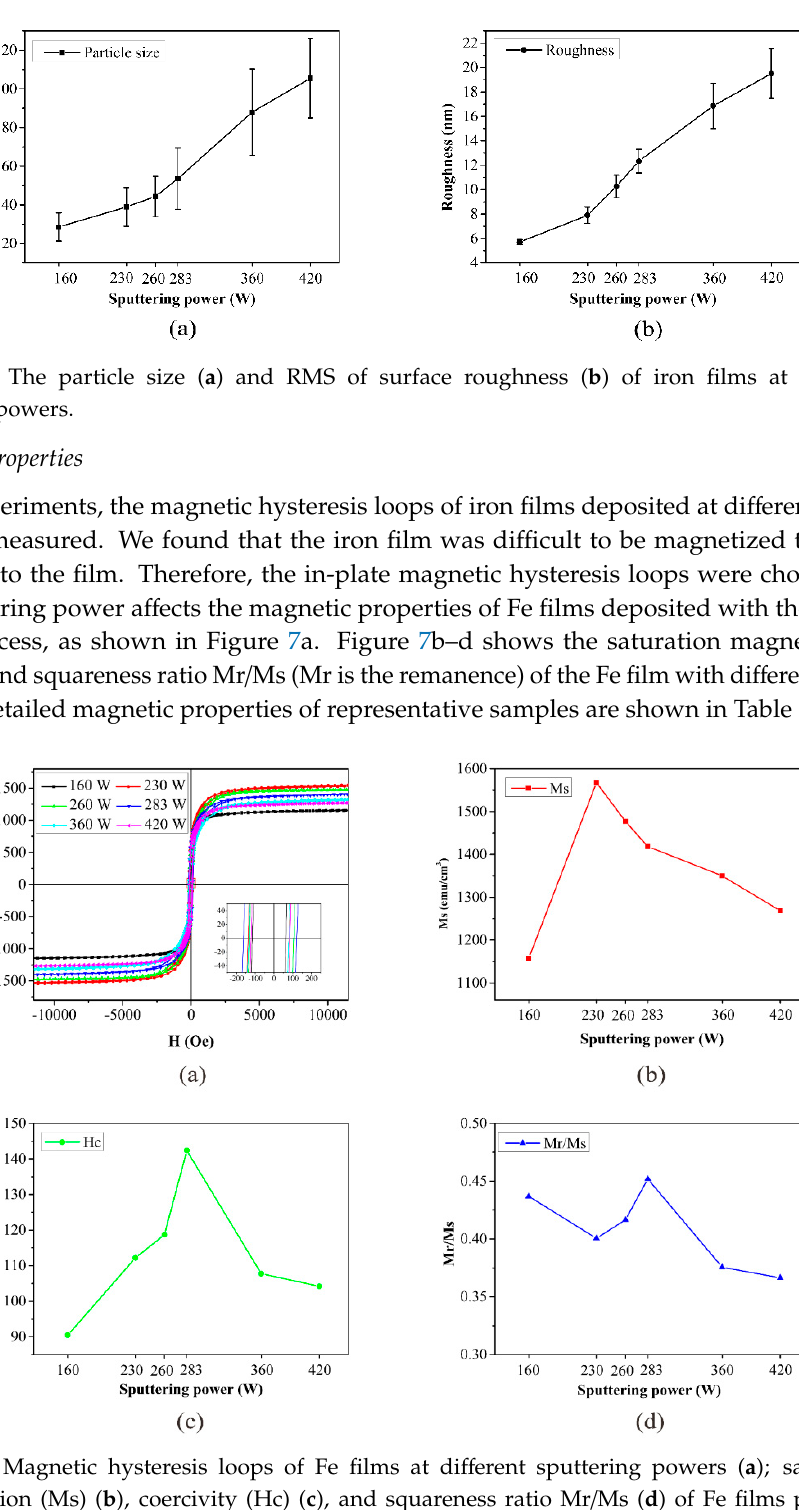
Figure 7. Magnetic hysteresis loops of Fe films at different sputtering powers ( a ); saturation magnetization (Ms) ( b ), coercivity (Hc) ( c ), and squareness ratio Mr/Ms ( d ) of Fe films prepared at different sputtering powers.